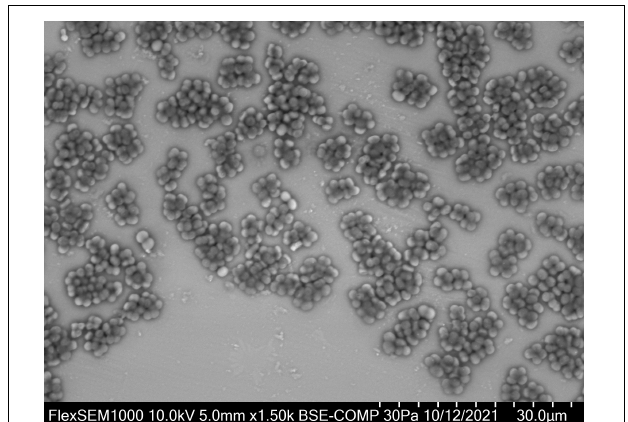
FIGURE 1 | Defluviicoccus vanus showing its distinctive cocci arranged in tetrads, and clusters of tetrads. For VP-SEM imaging, the D. vanus cells were grown on GS agar for 3 weeks. Individual colonies were selected and transferred onto a glass slide cut to the size of the specimen stub. Samples were visualized uncoated in a variable-pressure scanning electron microscope VP-SEM (Hitachi FlexSEM 1000 II) at 30 Pa and accelerating voltage of 10 kV, using a BSE